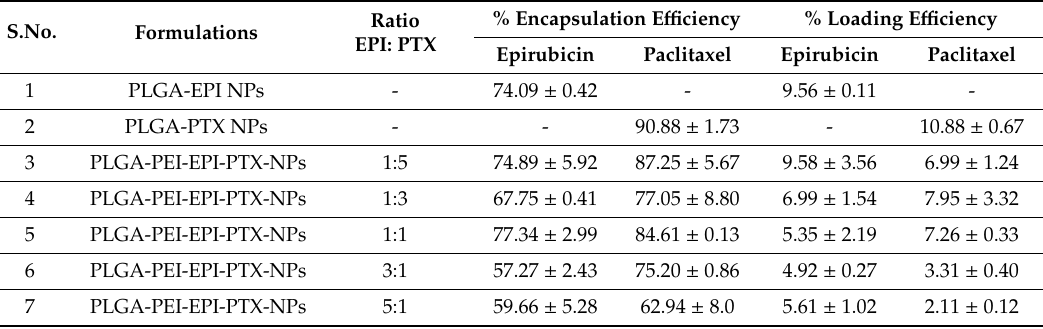
± SD ( n = 3). mean ± SD (n = 3).